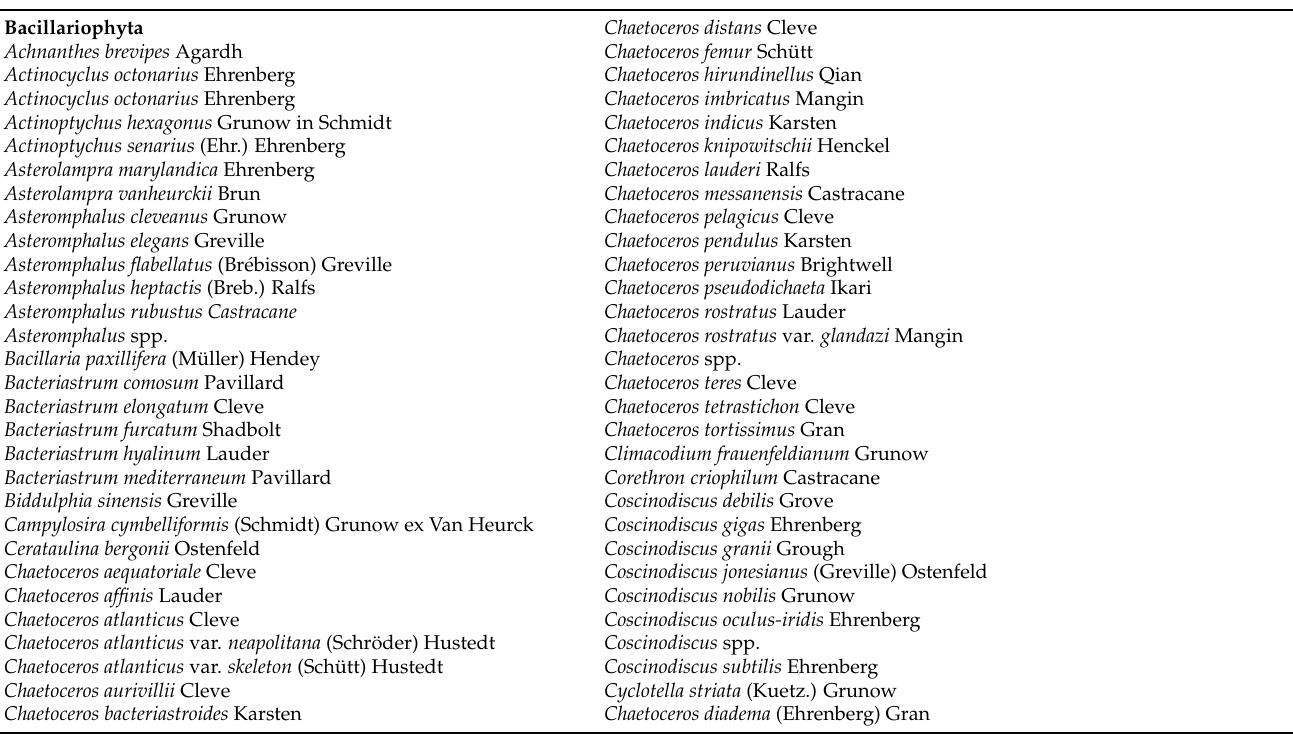
Table A1. Species list of the phytoplankton assemblage in the northern South China Sea,